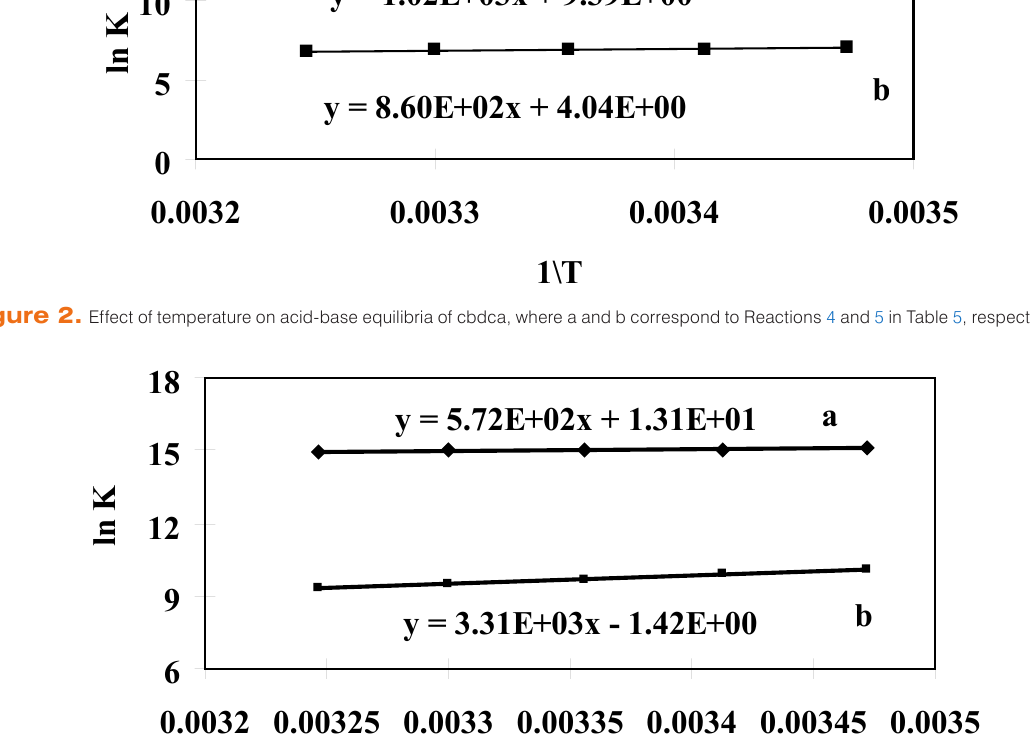
Figure 3. Effect of temperature on the stability of [Pd(DMPA)(CBDCA)], where a and b correspond to Reactions 6 and 7 in Table 5,